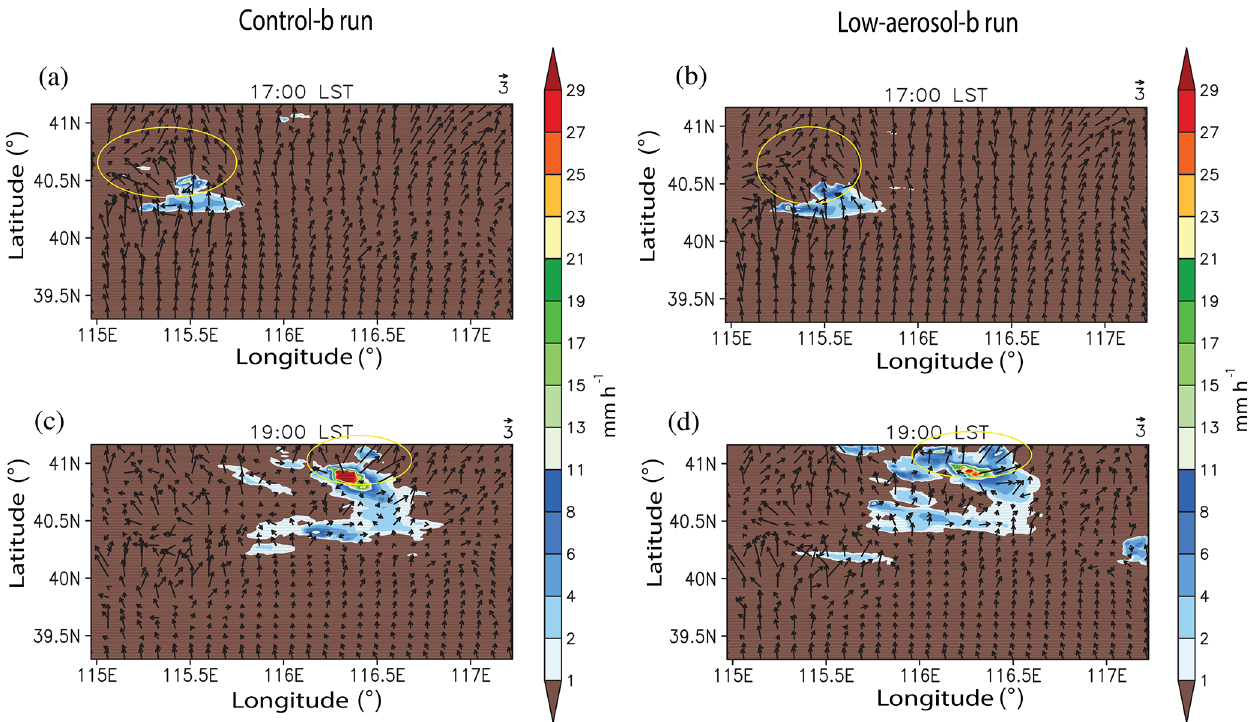
Figure 14. Spatial distributions of precipitation rates (shaded) and wind vectors (arrows) for the Beijing case at (a, b) 17:00LST, and (c, d) 19:00LST. The distributions in the control-b run are in (a, c) . The distributions in the low-aerosol-b run are in (b, d)